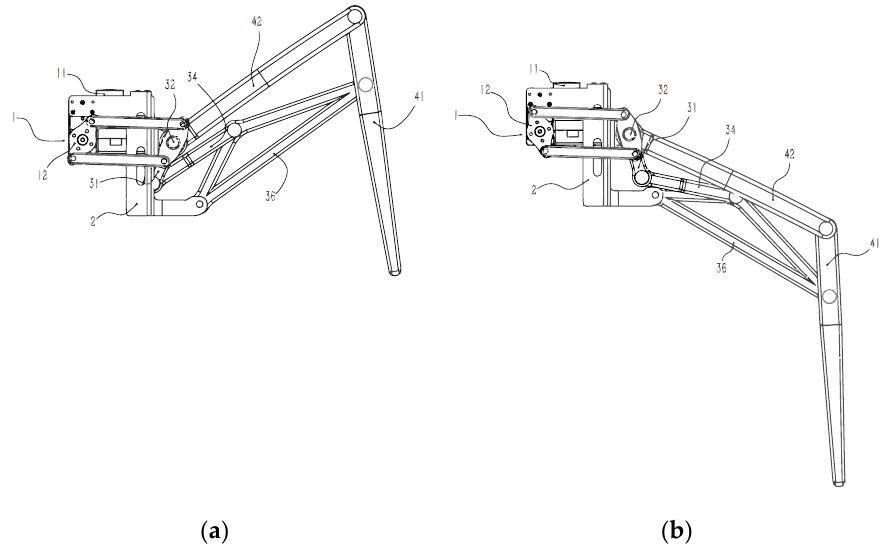
Figure 2. ( a ) A diagram of the leg mechanism moving to the lowest position and ( b ) a diagram of the leg mechanism moving to the highest position.